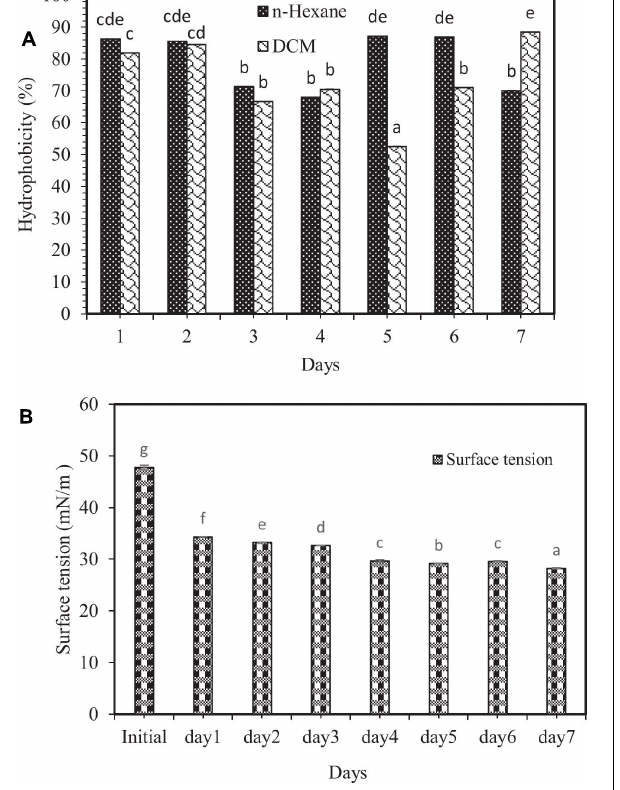
FIGURE 2 | (A) Changes in the percentage of cell surface hydrophobicity, and (B) surface tension variations in the modified 6SW-Vit medium amended with crude oil at 7 days. Means with the same letters are not significantly different at ( P ≤ 0.01). Error bars are not clearly visible because they are shorter than the symbol size and represent the standard deviation ( n = 3). DCM and n-hexane are the abbreviations of dichloromethane and normal-hexane,